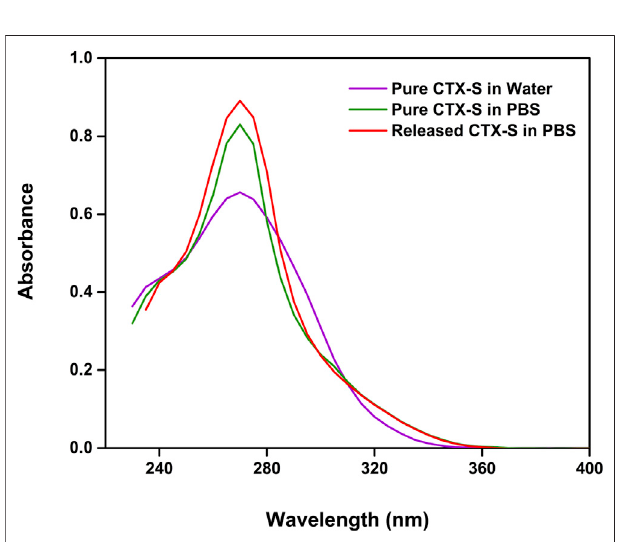
FIGURE 8 | The chemical activity of the pure CTX-S and after release from the